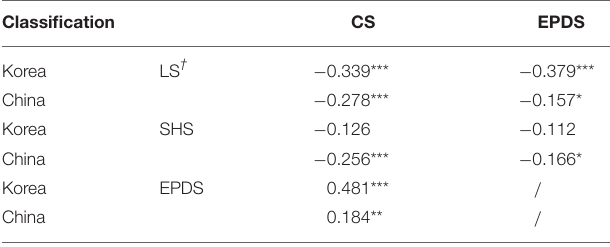
TABLE 5 | Correlation coefficients between childcare stress, postpartum depression, life satisfaction and satisfaction with husband support by country.